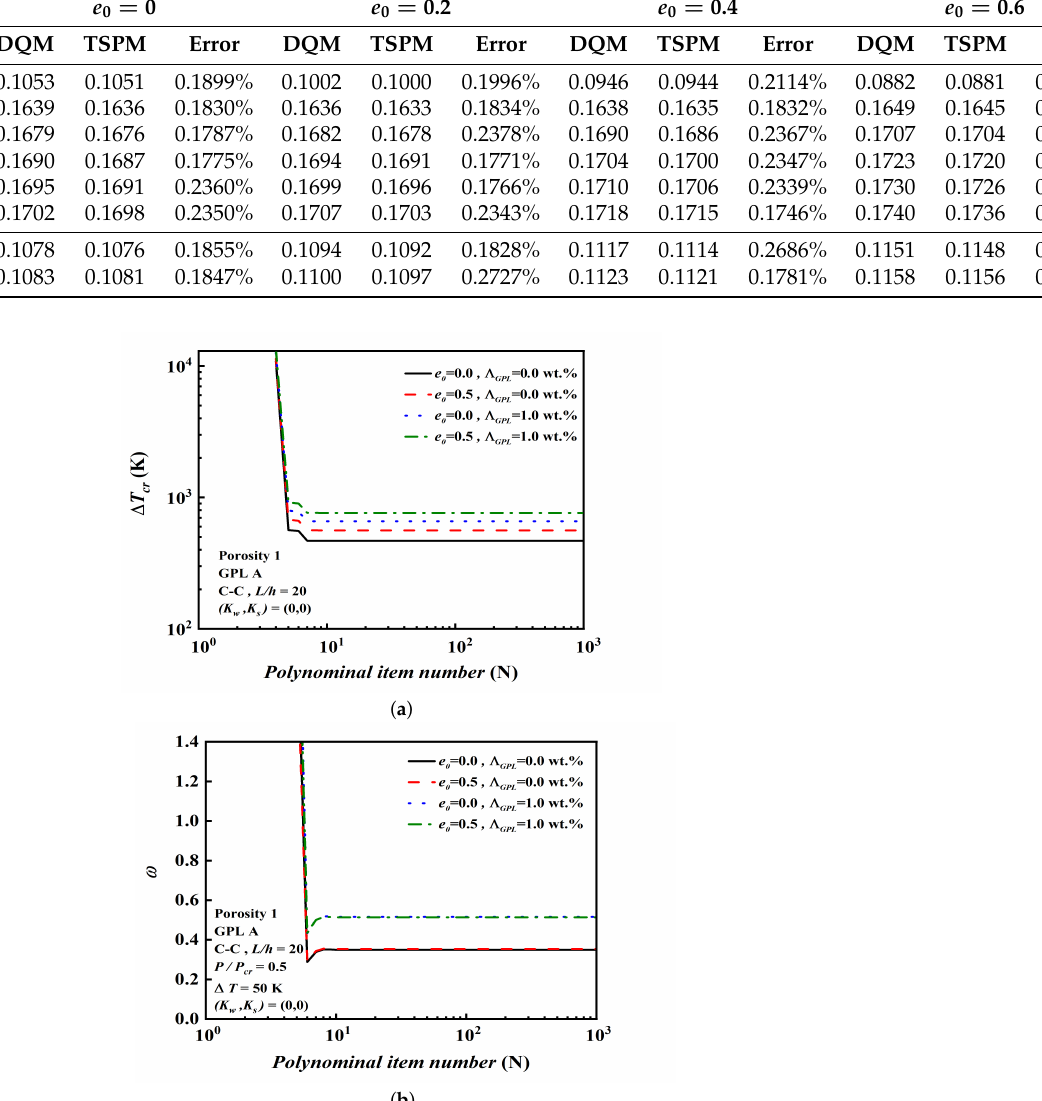
Figure 4. Determine polynomial item number (N). ( a ) Determine polynomial item number (N) of the critical buckling temperature rise. ( b ) Determine polynomial item number (N) of the dimensionless fundamental